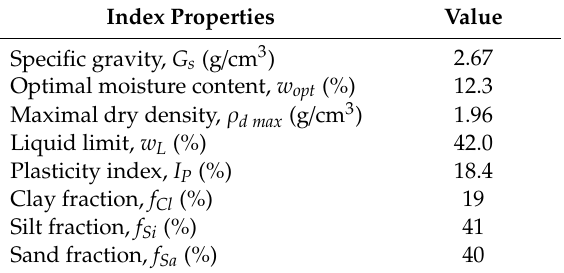
Table 1. Index properties of tested sandy silty